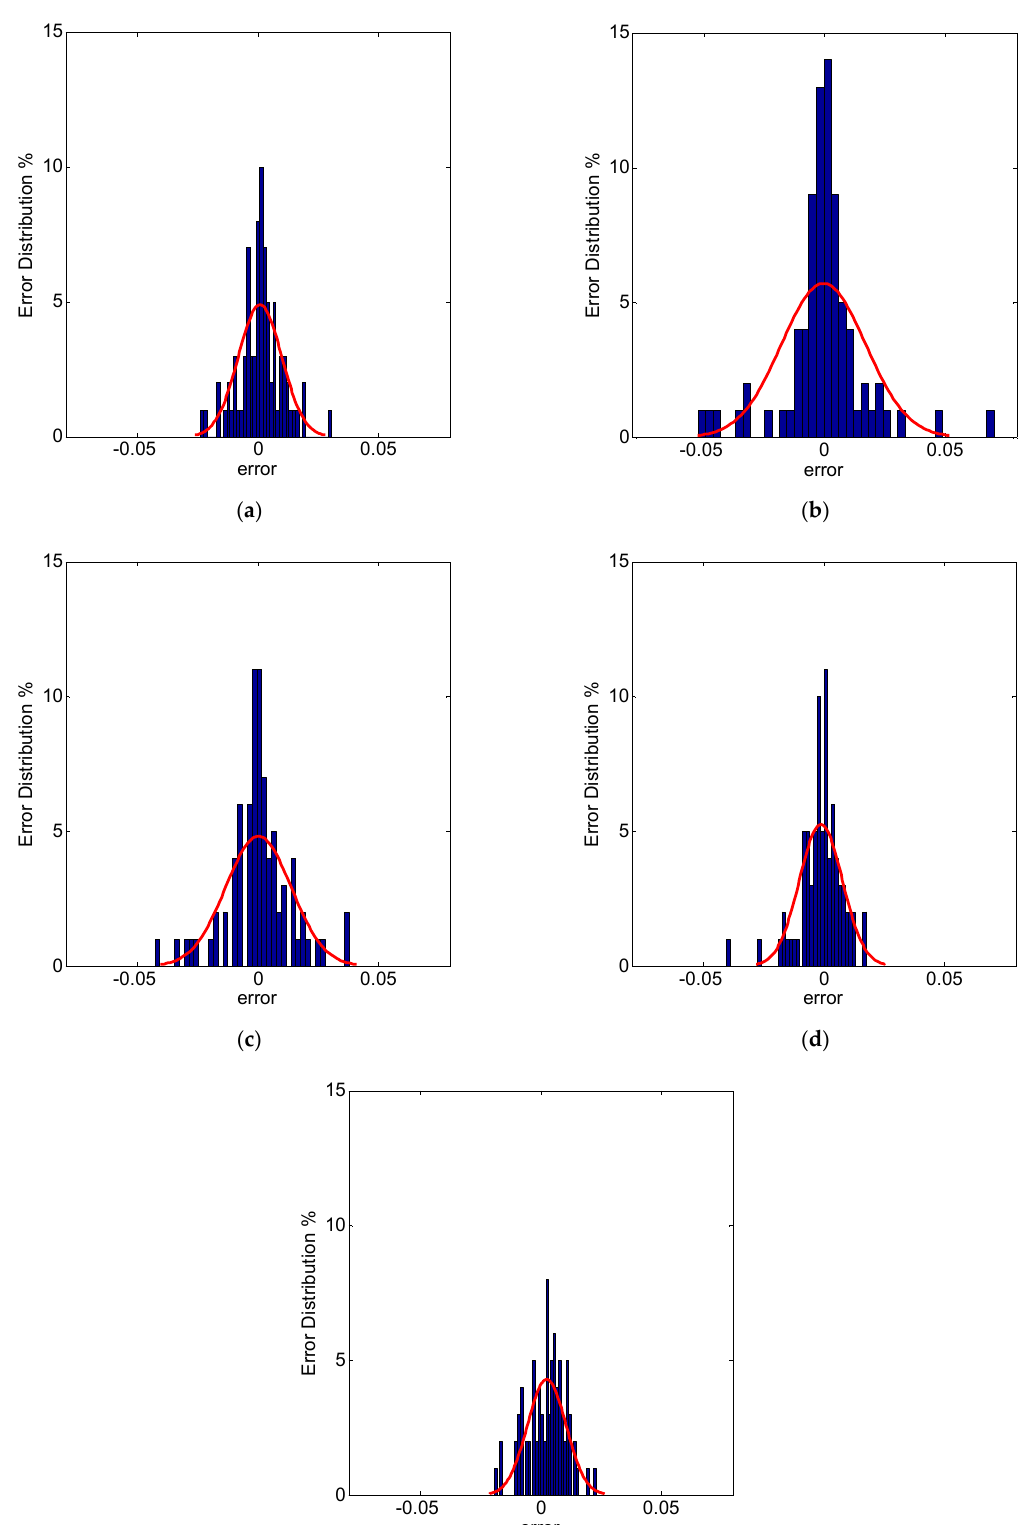
Figure 5. Histogram of error distribution for CO 2 solubility in ILs prediction by proposed model. ( a ) BP, ( b ) SVM, ( c ) ELM, ( d ) linear fusion model I and ( e ) linear fusion model II.